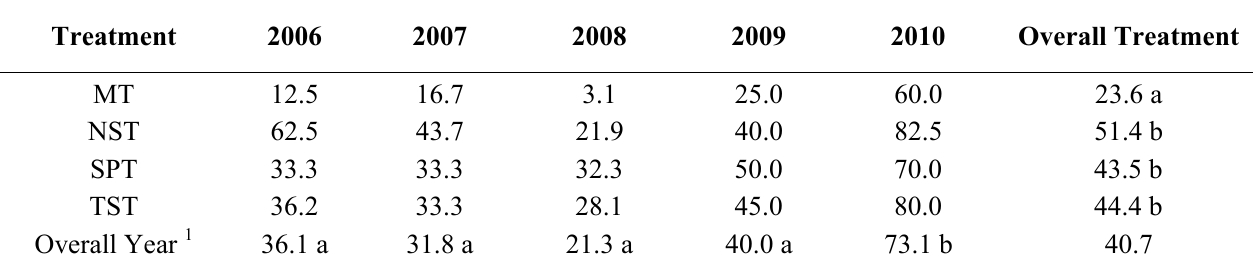
Table 1. Percentages of lambs that reached slaughter weight of 38 kg in each year following treatment under one of four different anthelmintic